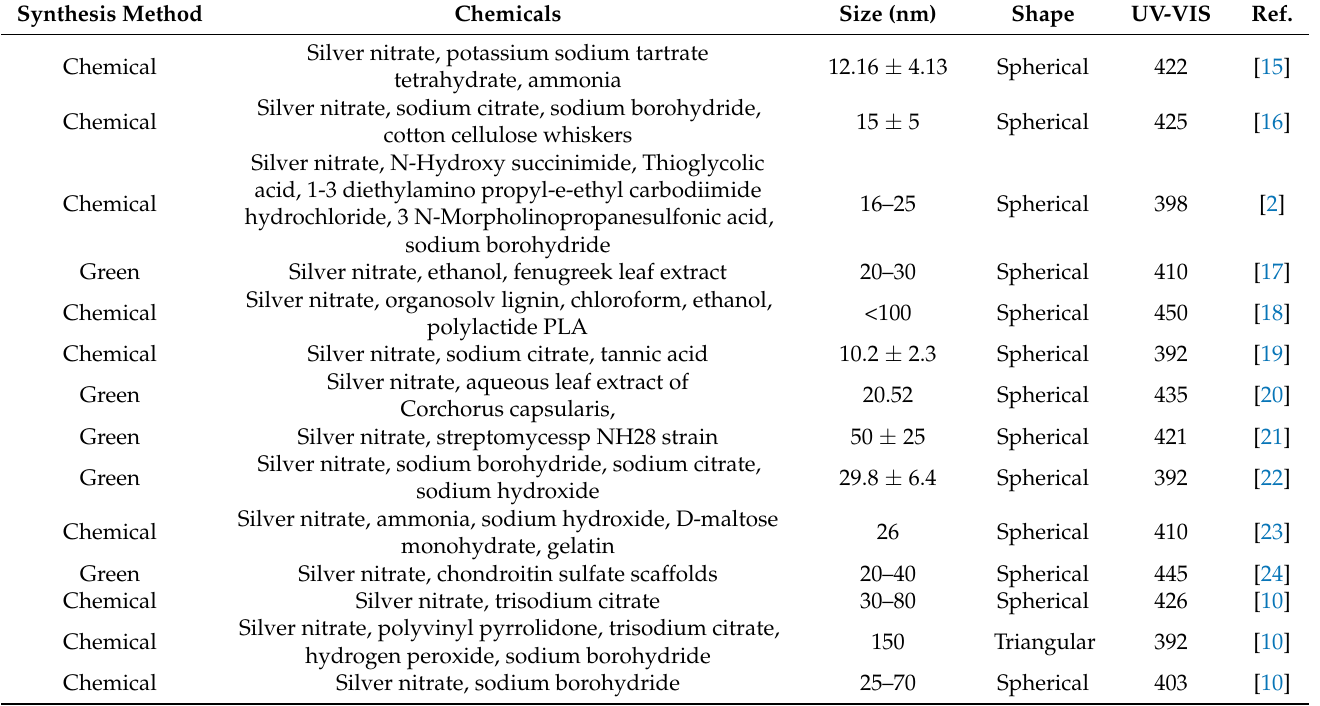
Table 1. Silver nanoparticles characterized using UV-VIS obtained with various methods. Synthesis